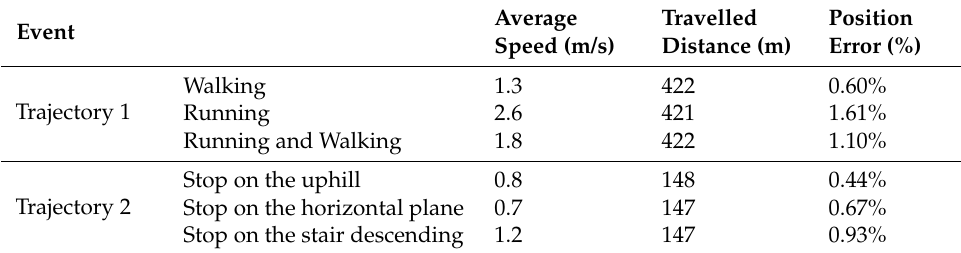
Table 1. Field test return position